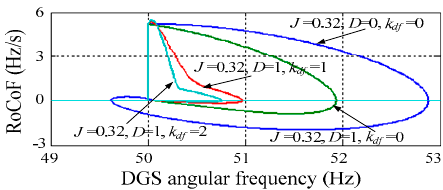
Figure 11. Angular frequency-acceleration curves of DGS with virtual inertia, virtual damping, or differential feedforward control loop.